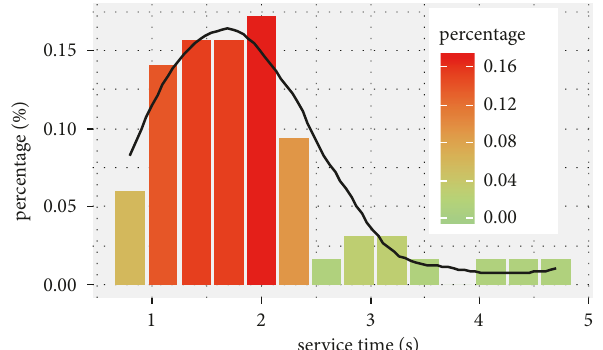
Figure 6: The service time of ticket gate based on field